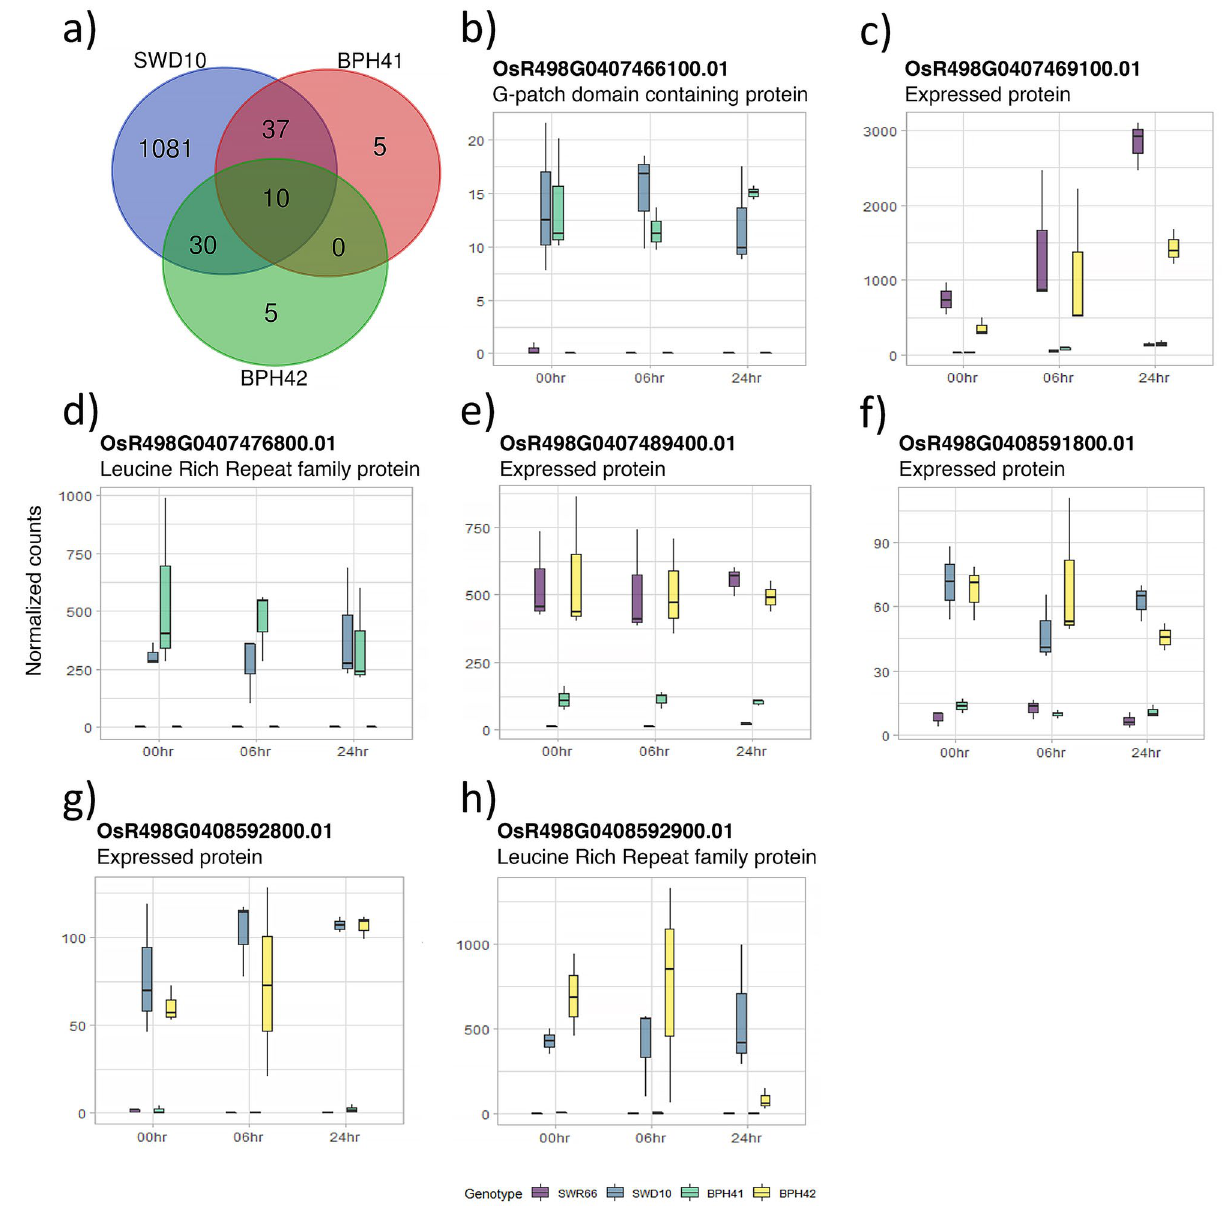
in the SWR66 background except parental and control lines. ( a ) Venn diagram illustrating the number of differentially expressed genes compared to SWR66 for SWD10, BPH41 and BPH42 genotypes at 0 h. The cut-off values used to identify DEGs of interest are, p value < 0.001 and absolute log 2 fold change > 2. ( b – h ) boxplot of normalized count values for seven shortlisted genes in BPH41 and BPH42 QTLs. Normalized gene counts for three timepoints, 0 h, 6 h and 24 h and four genotypes are illustrated. Boxplots ( b – e ) are gene candidates located within BPH41 and boxplots ( f – h ) are gene candidates located within